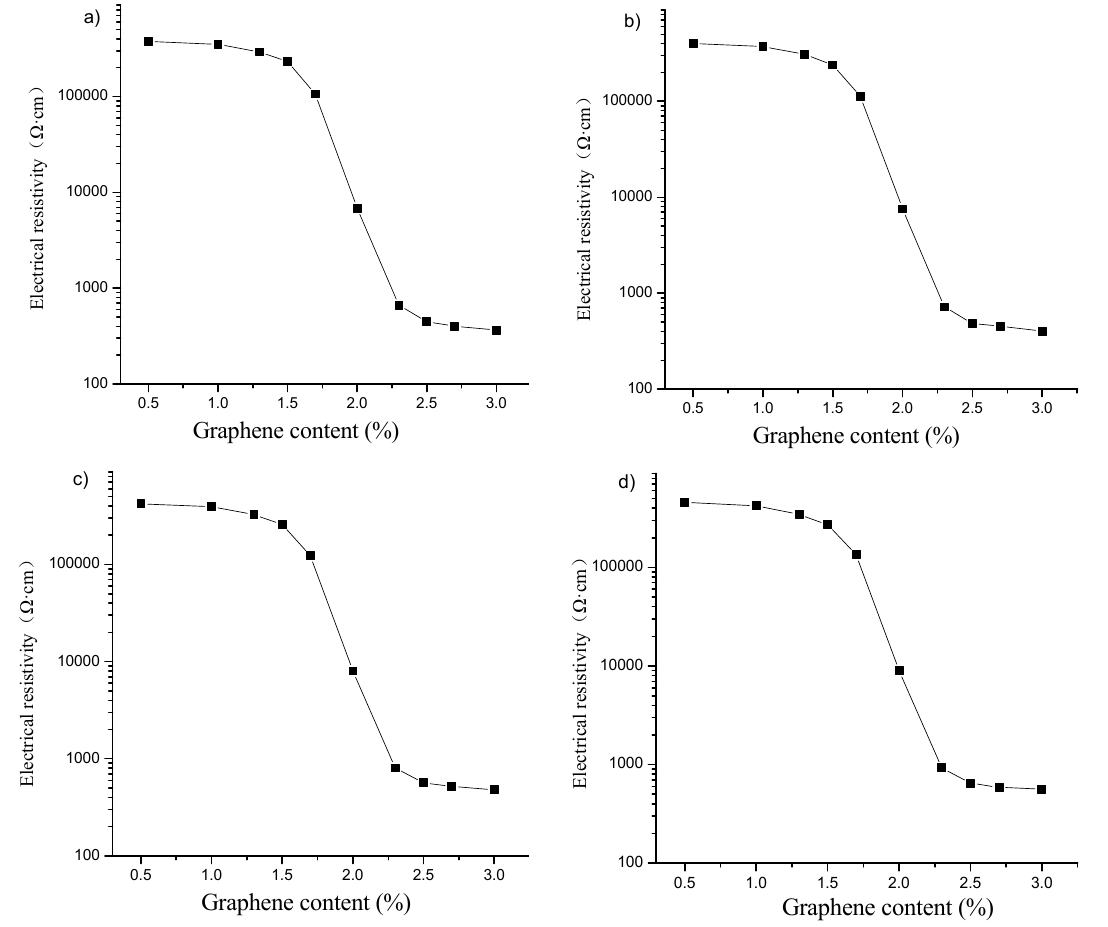
Figure 4. Electrical resistivities of specimens with different graphene contents after different freeze–thaw cycles: ( a ) 25; ( b ) 50; ( c ) 75; ( d ) 100. Figure 5 shows the relative change rate of electrical resistivity of the specimen after different freeze–thaw cycles. As shown in Figure 5, in the case of the same graphene content, the relative change rate of electrical resistivity of the specimen increases gradu- ally with the increase of the number of freeze–thaw cycles, and they are all greater than zero. When the graphene content is in zone A, when the content of graphene is in zone A, graphene is isolated and dispersed in the specimen, and the gap between particles is large. The specimen mainly depends on the ion conduction in the cement matrix. At this time, the freeze–thaw causes the matrix to produce new cracks, and the pore size of the cracks increases, reducing the ionic conductivity and increasing the resistivity. Under the same number of freeze–thaw cycles, with the increase of graphene content, the freeze– thaw resistance of the specimen enhances, and the relative change rate of resistivity de- creases. When the graphene content is in zone B, the distance between graphene particles decreases gradually with the increase of graphene content. When the particles are close enough, although there is no contact, the carriers can obtain enough energy from the outside to arrive at another conductor from one conductor, and electronic transition oc- curs to form tunneling conduction, which is dominant in zone B. The cracks caused by freeze–thaw increase the distance of some graphene particles, destroy their occurrence of tunneling conduction, and increase the resistivity. This is essentially different from the influence of freeze–thaw on the resistivity of zone A, and the influence is greater. Thus, under the same number of freeze–thaw cycles, the relative change rate of resistivity first increases rapidly and then stabilizes with the increase of the graphene content. When the